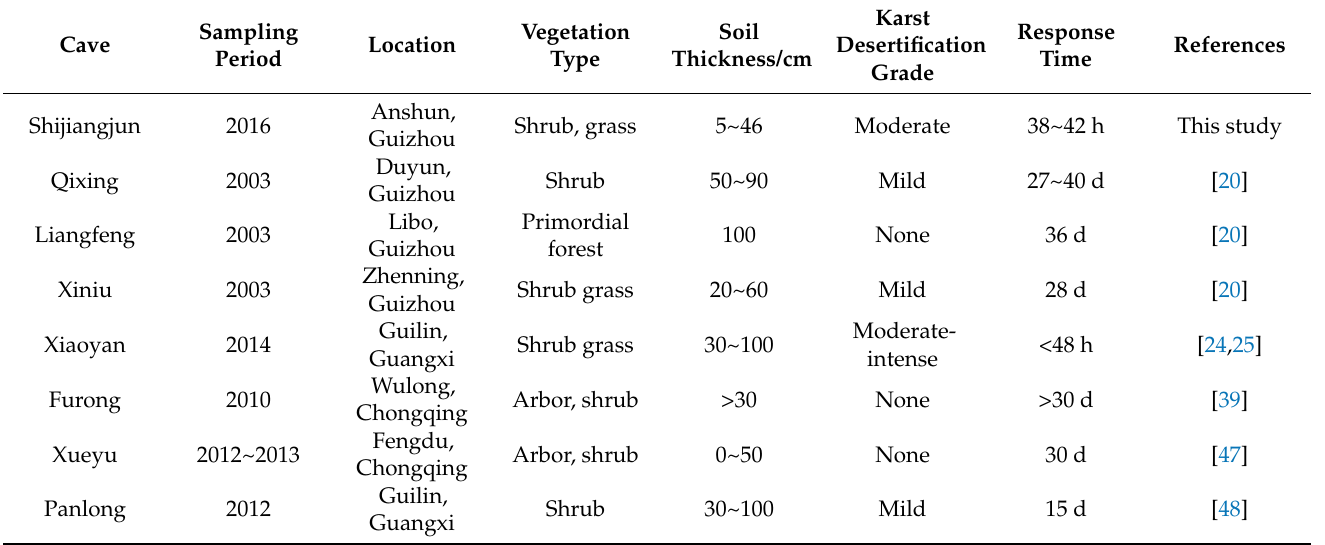
Table 3. Comparison of the drip water response time to precipitation among different grades of karst rocky desertification regions in the rainy